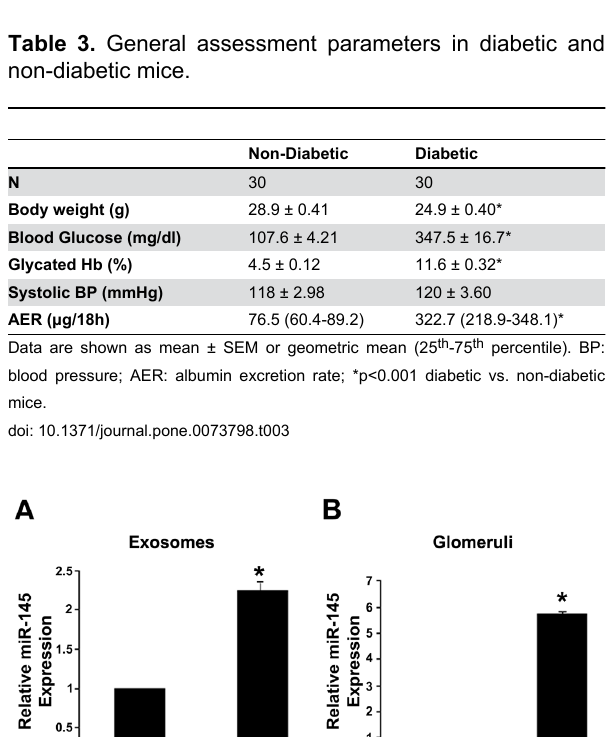
Table 3. General assessment parameters in diabetic and non-diabetic mice.